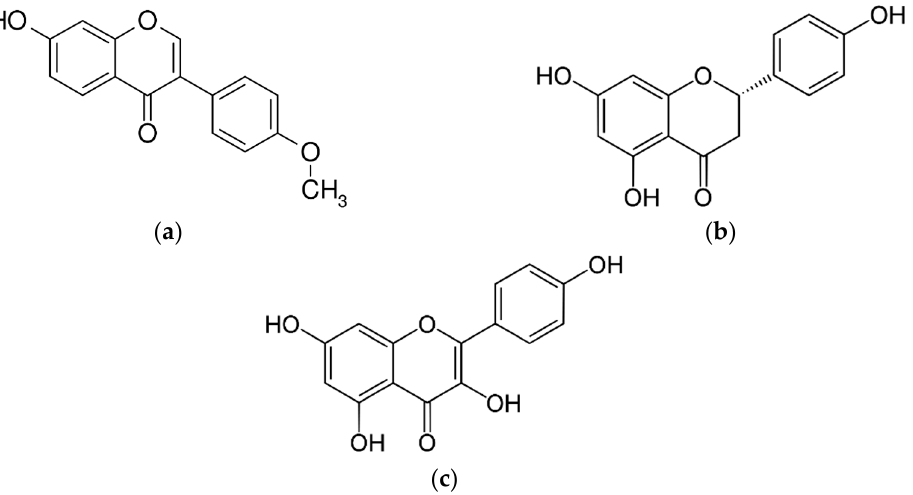
Figure 6. Chemical structures of phenolic compounds ( a ) Formononetin; ( b ) Narigenin; and ( c ) Kaempferol.